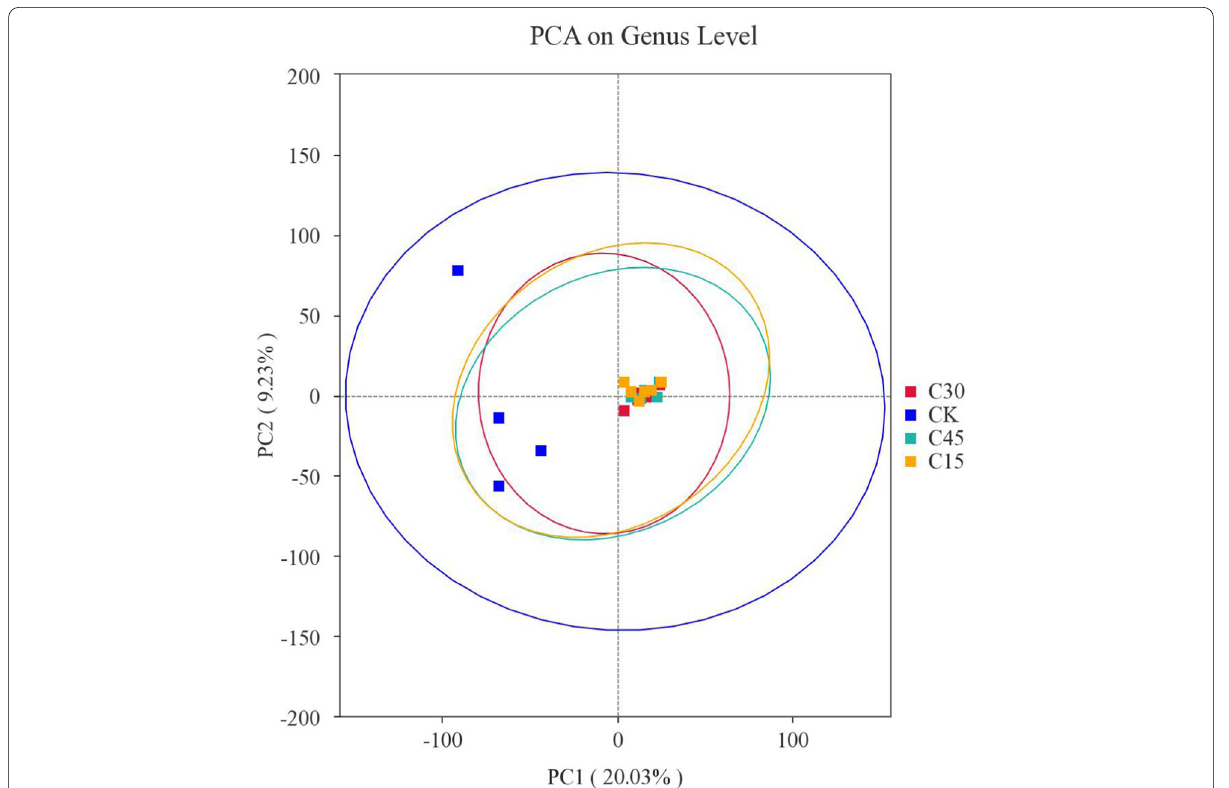
Fig. 5 Principal component analysis of soil microorganisms under different oil pollution